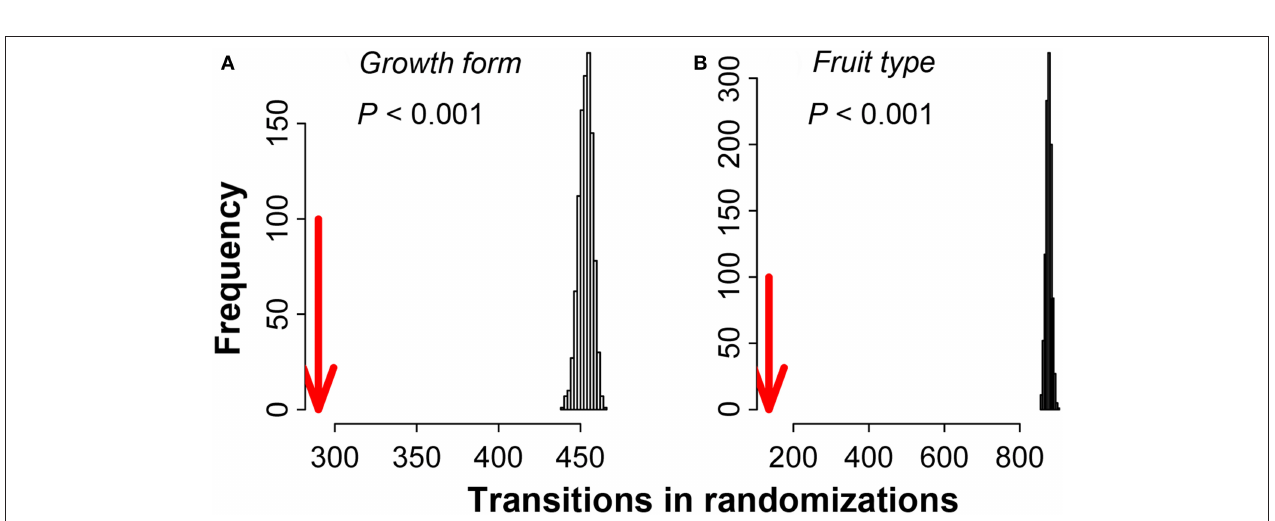
FIGURE 4 | Results of the randomization test of the two categorical traits, growth form (A) and fruit type (B) , along the phylogenetic tree of the total seed plants of Mount Kenya from 2,000 to 5,000m a.s.l. The red arrows are the evolutionary transitions observed in functional traits and the bars indicate evolutionary transitions randomized from minimum to maximum.